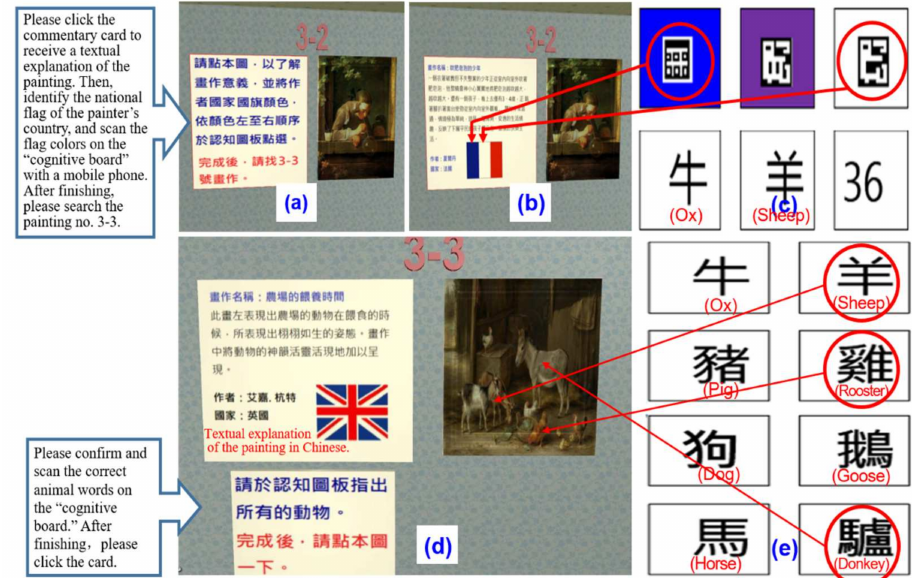
Figure 5. Memory test screen: ( a ) Instructions screen for the start of the short-term memory test; ( b ) Text explanation of the painting; ( c ) Confirm the color of the national flag and scan code on the cognitive board; ( d ) Instructions screen for the start of the long-term memory test; ( e ) Confirm and scan the correct animal words on the cognitive